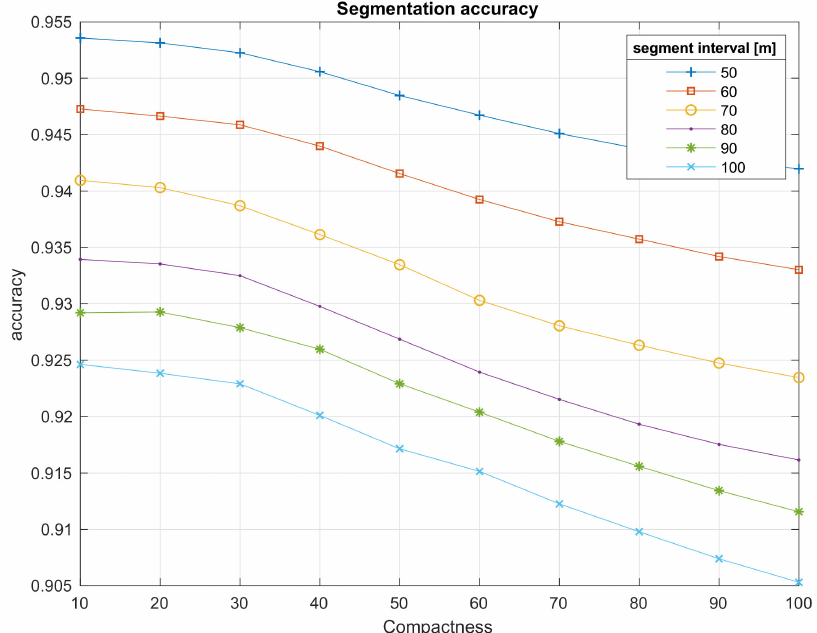
Figure 6. Segmentation accuracy as function of the two parameters to be tuned: compactness (m) and spatial interval (S).